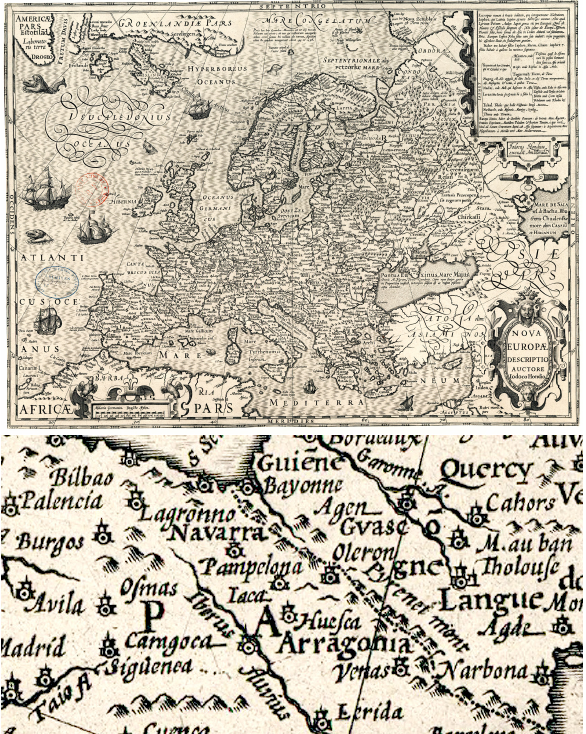
Figure 5: Jodocus Hondius (the elder), 1611, Nova Europæ : Dashed